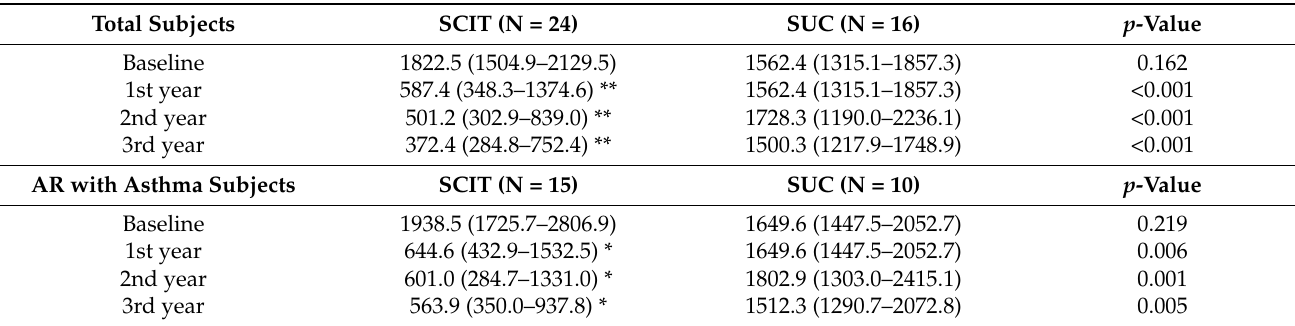
Table 3. Total medication cost per month (Thai baht (THB)) before and during three years of treatment between SCIT and SUC groups in AR subjects with or without